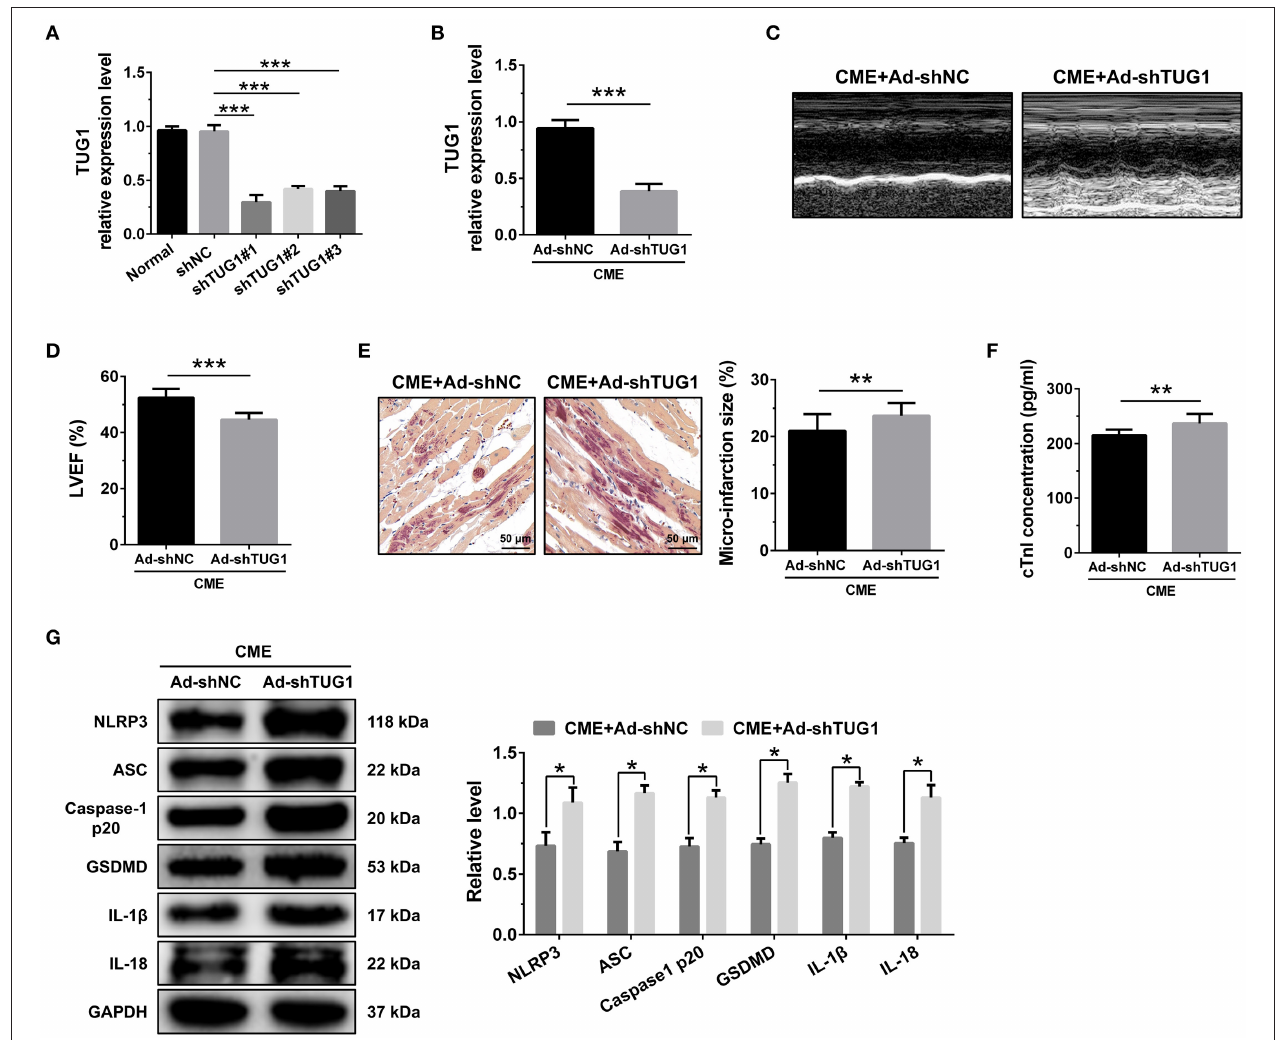
FIGURE 3 | TUG1 depression exacerbates myocardial damage and pyroptosis following CME. (A) TUG1 shRNAs successfully decreased TUG1 level in H9C2 cells ( n = 3). (B) Transfection with AAV-TUG1-shRNA significantly decreased myocardial TUG1 level following CME ( n = 10). (C) Echocardiography was used to assess cardiac function and to quantify (D) LVEF ( n = 10). (E) HBFP staining was used to measure microinfarct size ( × 200; scale bar = 50 µ m) ( n = 10). (F) cTnI parameters for rats in each group ( n = 10). (G) Western blotting was used to quantify myocardial NLRP3, ASC, caspase-1 p20, GSDMD, IL-1 β , and IL-18 protein levels with GAPDH as a normalization control ( n = 3). Data are mean ± SEM from three or more independent experiments. * P < 0.05, ** P < 0.01, *** P <